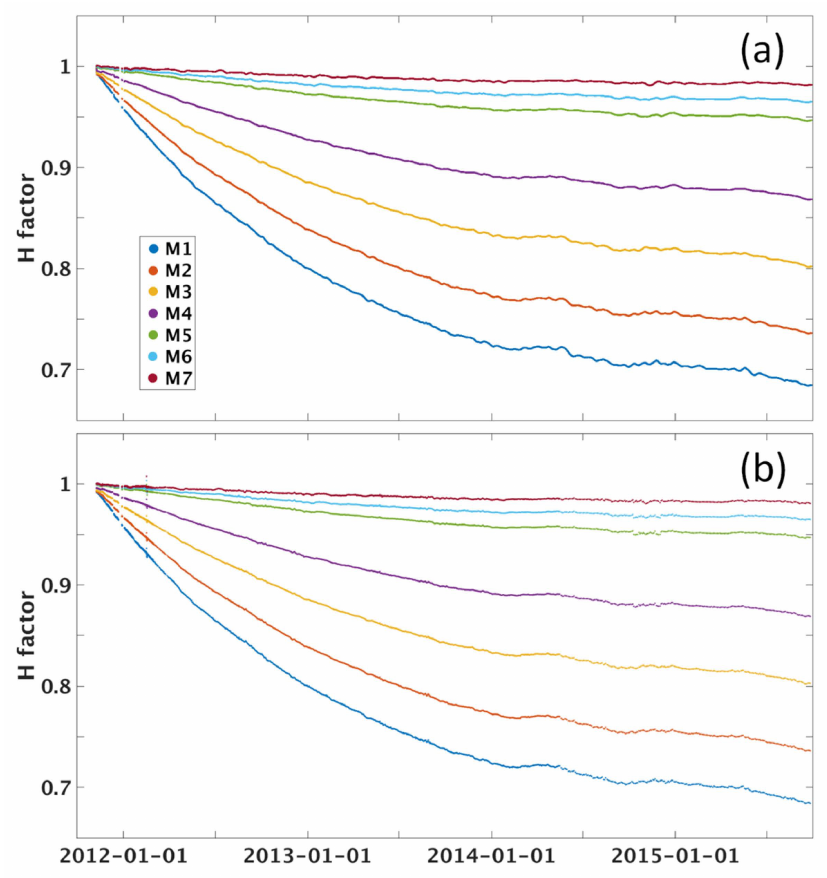
Figure 2. Degradation of the Suomi NPP VIIRS solar diffuser reflectance (the H factor) for bands M1–M7 as measured by the SDSM and analyzed by the automated calibration procedure with ( a ) and without ( b ) the time series